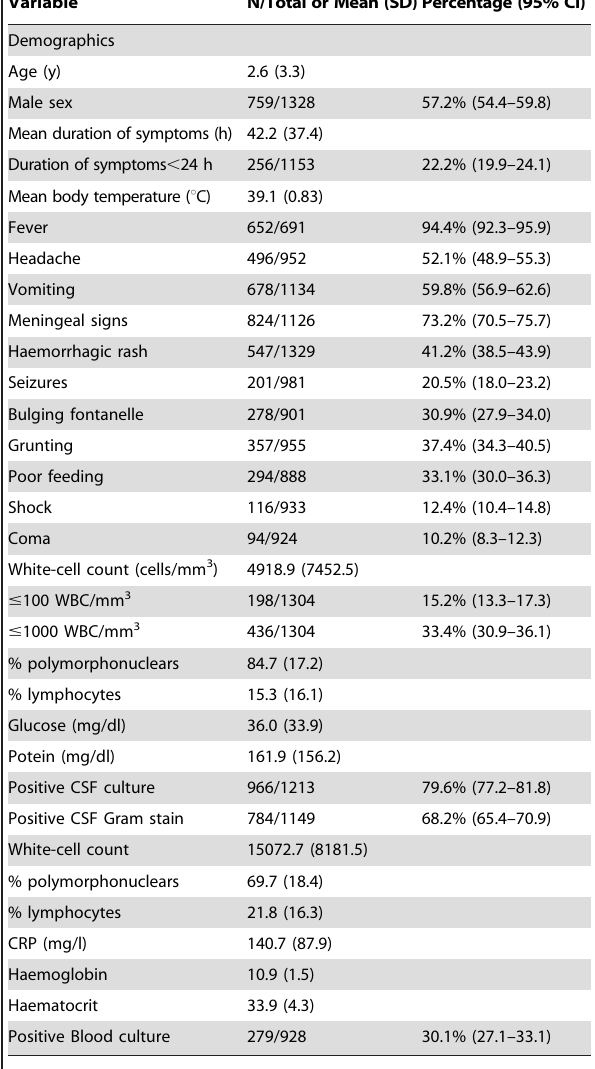
Table 2. Characteristics of the study